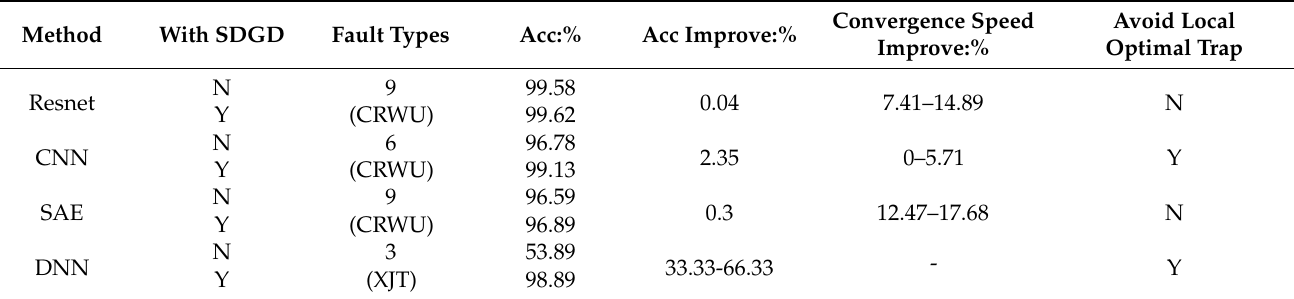
Table 13. Methods